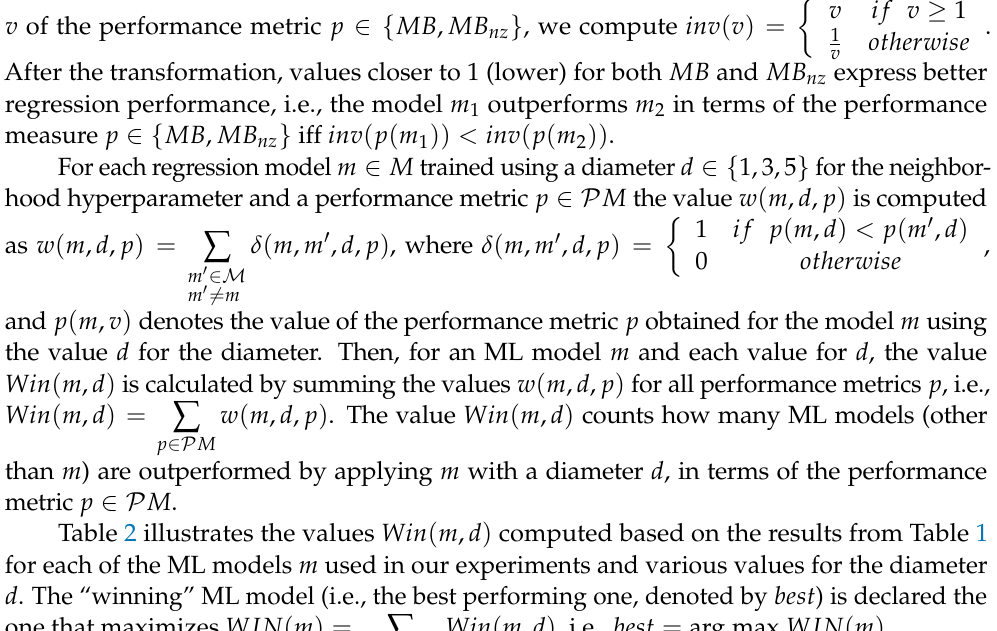
Table 2. The values for Win ( m , d ) computed for each machine learning model m ∈ M and each value d ∈ { 3,5,7 } . The last row depicts, for each ML model m , the values for WIN ( m ) . d DNN SVM k NN RF Stack PLS Stack DNN 3 13 9 14 18 22 15 5 12 9 13 18 23 16 7 16 10 13 17 23 14 WIN 41 28 40 53 68